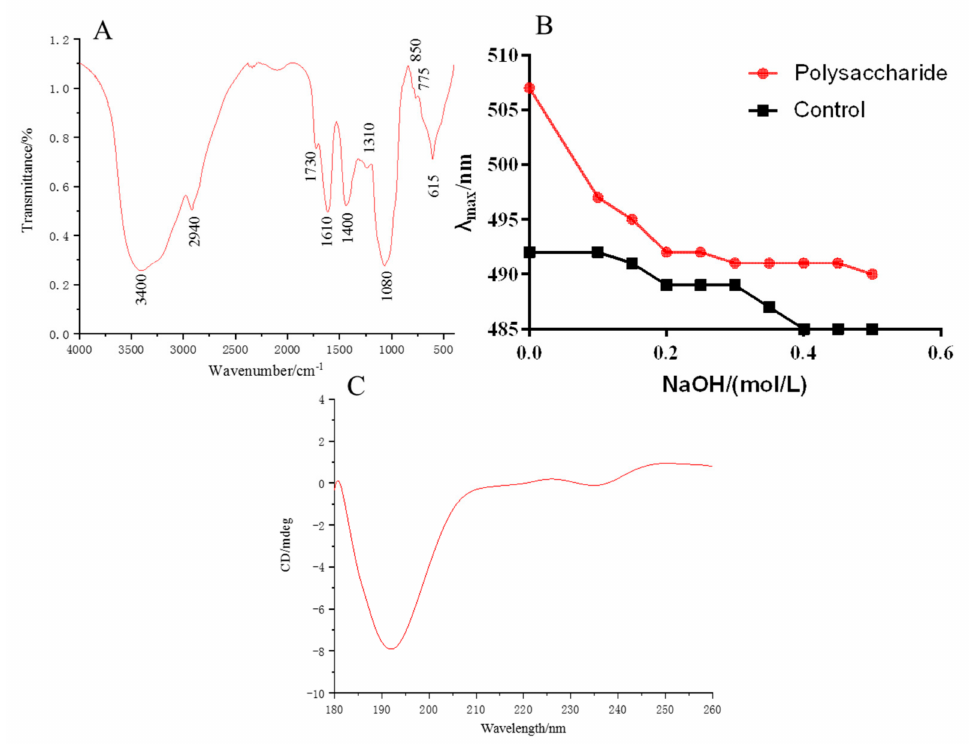
Figure 3. FT-IR spectra of polysaccharides ( A ), maximum absorption wavelength of polysaccharides-Congo red ( B ) and CD chromatogram ( C